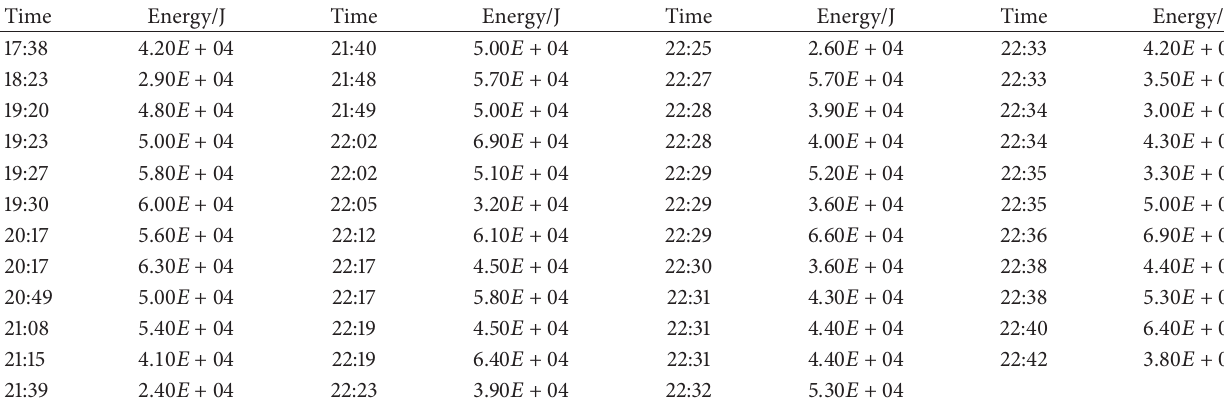
Table 3: Microseismic monitoring data on the 22nd of April.